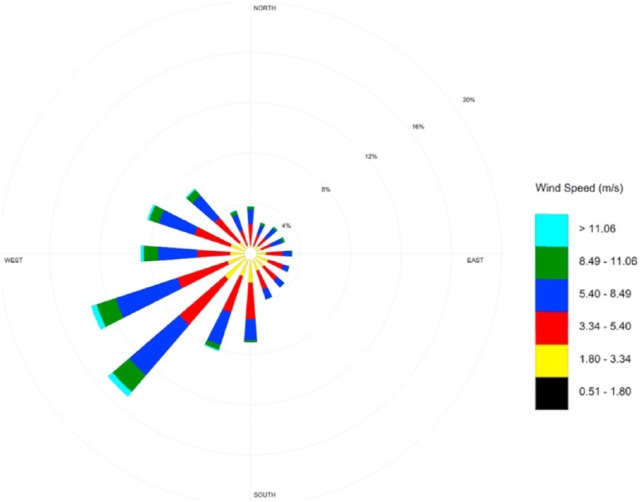
Wind rose diagram of the CVS area.1CVS, Chemical Valley Sarnia.